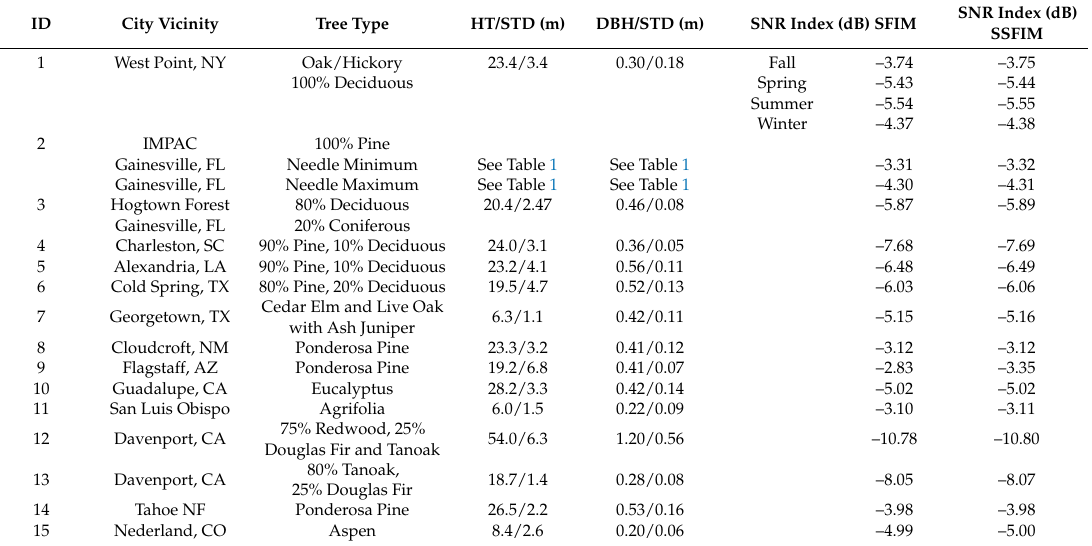
Table 3. Absorption indexes of the forest study sites showing the results of the signal to noise forest index model (SFIM) and simplified signal to noise forest index model